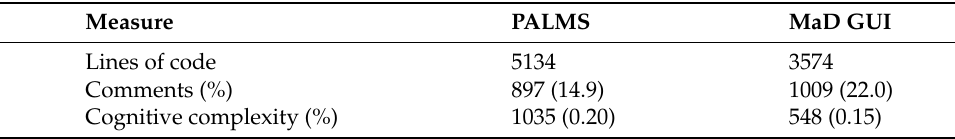
Table 2. Static code analysis. Percentage values are relative to lines of code.